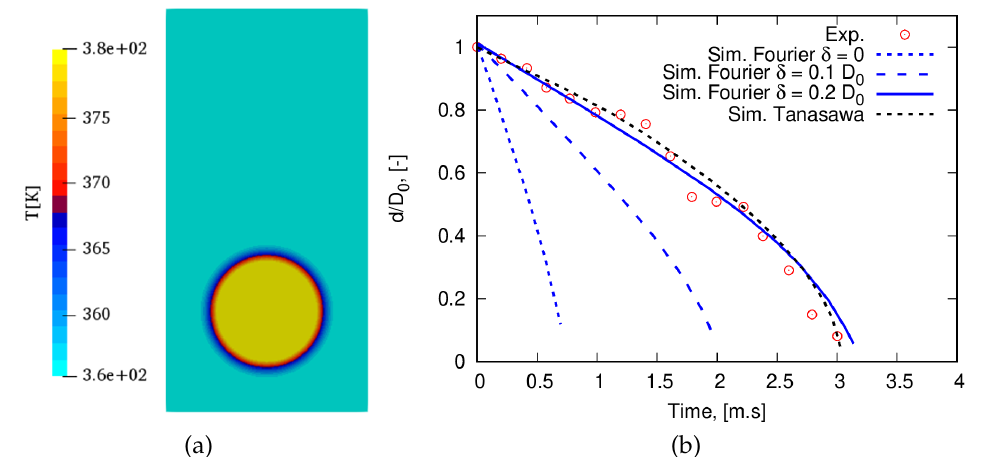
Figure 5. ( a ) The initial temperature profile (thermal layer thickness δ ∼ 0.2 D 0 ), ( b ) vapor bubble lifetime from the present numerical simulation (Fourier model) vs. experimental data taken from [43] and the simulation with the Tanasawa model